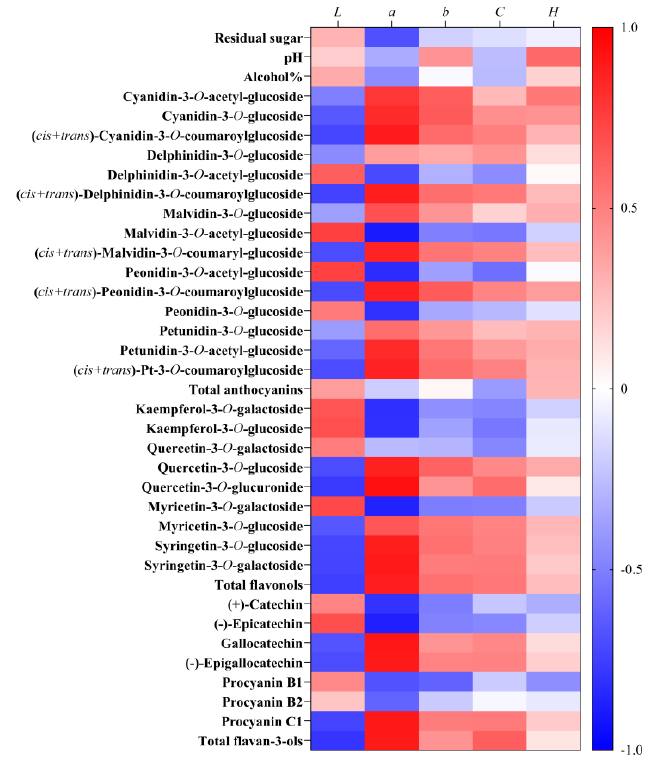
Figure 8. Pearson correlation analysis revealing the relationships between the wine colorimetric parameters and the residual sugar, pH value, alcohol level and the flavonoids.